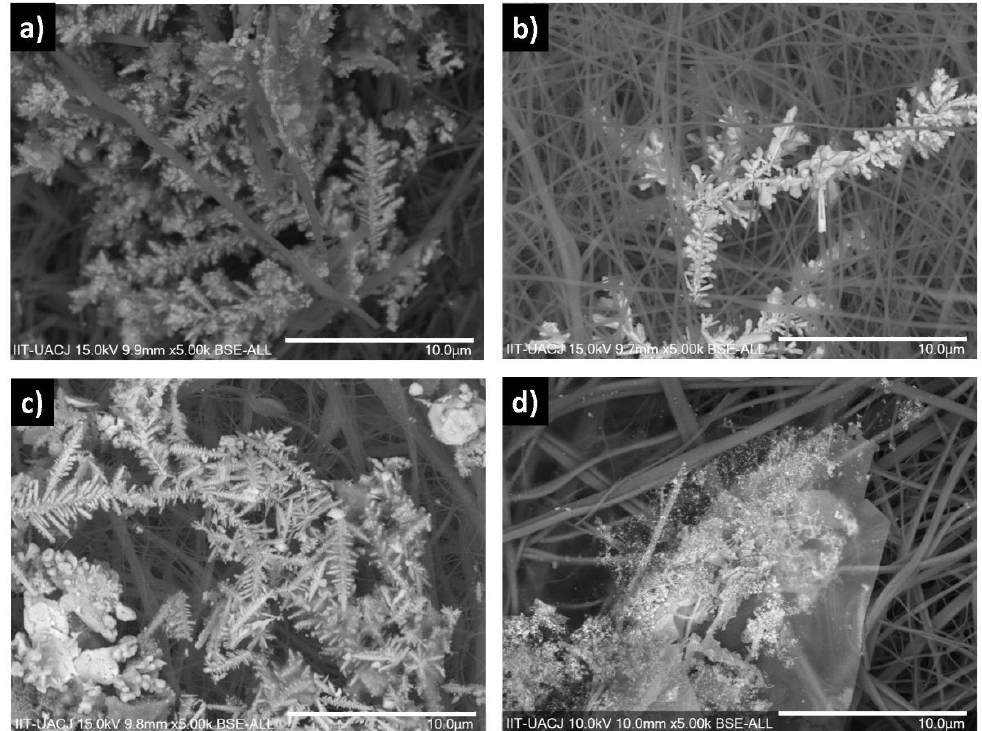
Figure 4. SEM micrographs of silver-doped fibers at 10 mM AgNO 3 during: ( a ) 1, ( b ) 2, ( c ) 5 and ( d ) 10 min.